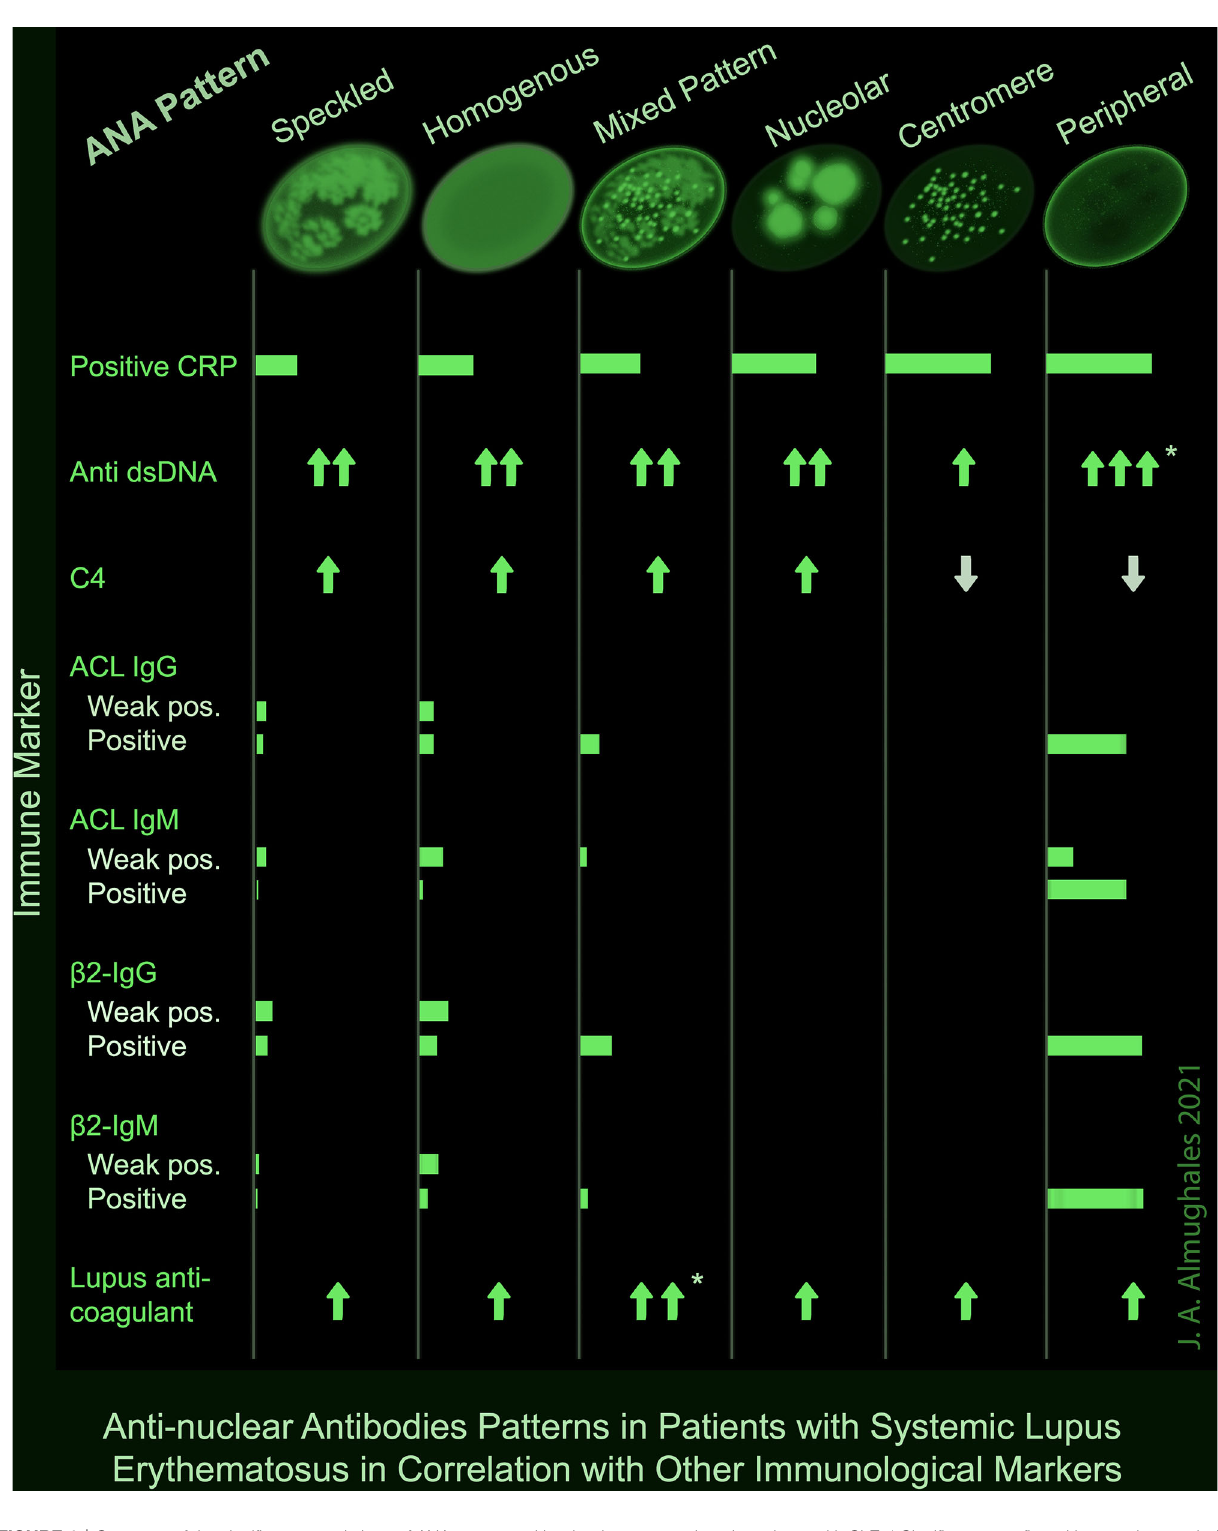
Frontiers in Immunology |